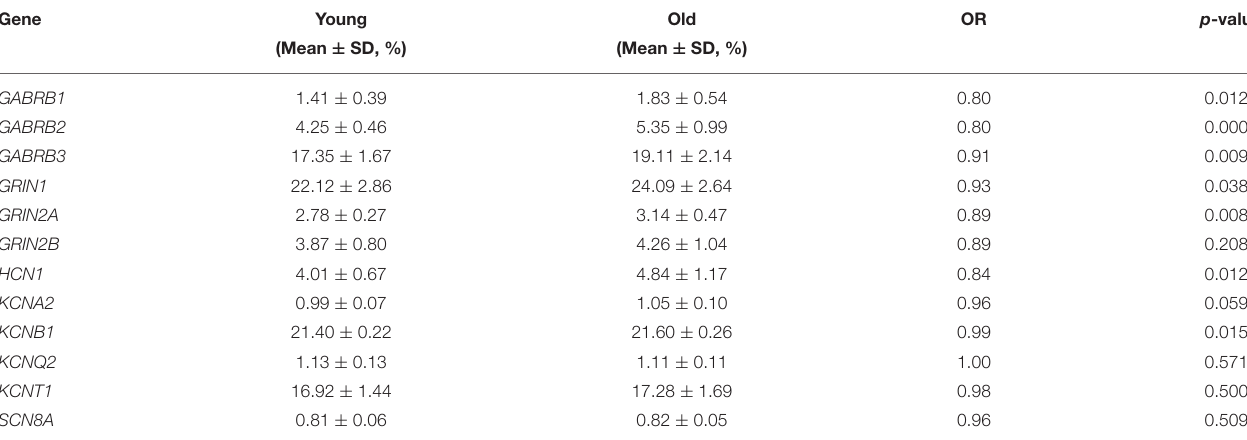
TABLE 5 | DNA methylation of 12 ion-channel genes between young and old patients.